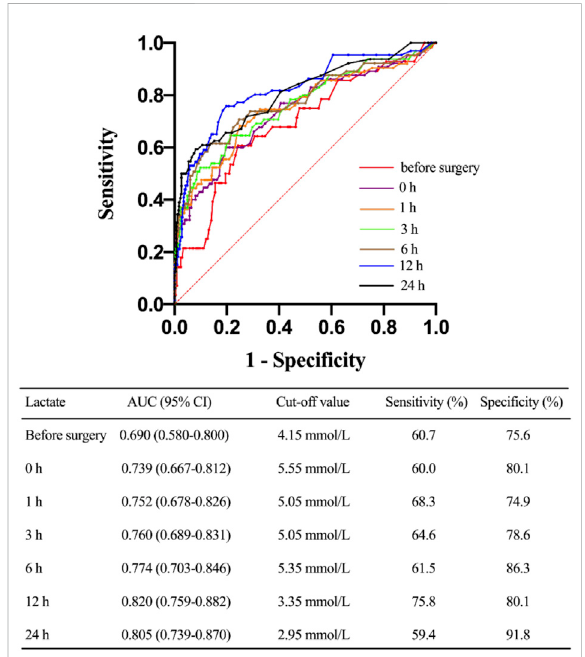
FIGURE 4 Characteristic of receiving operating curves evaluating the predictive power of different timepoints of lactate levels for 30- day mortality. CI, con fi dence interval.